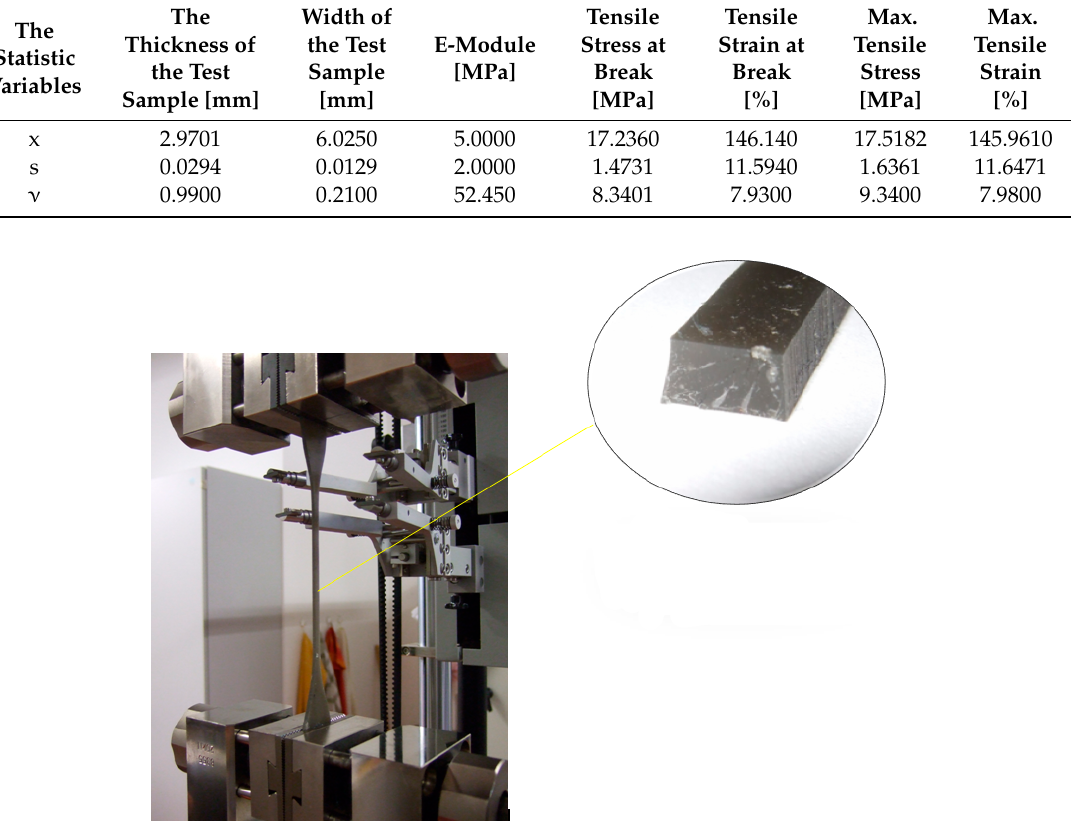
Figure 7. Tensiletestofrecycledpolyvinylbutyral( leftside —sampleheld, rightside —PVBzoomed50 × ). Figure 7. Tensile test of recycled polyvinyl butyral ( left side — sample held, right side — PVB zoomed With increasing deformation, the force increases. The force is required to maintain a constant 50 × ). feed speed of the jaw the tensile machine. The tensile test works on the principle of stressing the test specimen until the time [32], when the sample ruptures, which indicates the value of tensile stress at break σ B (17.2360